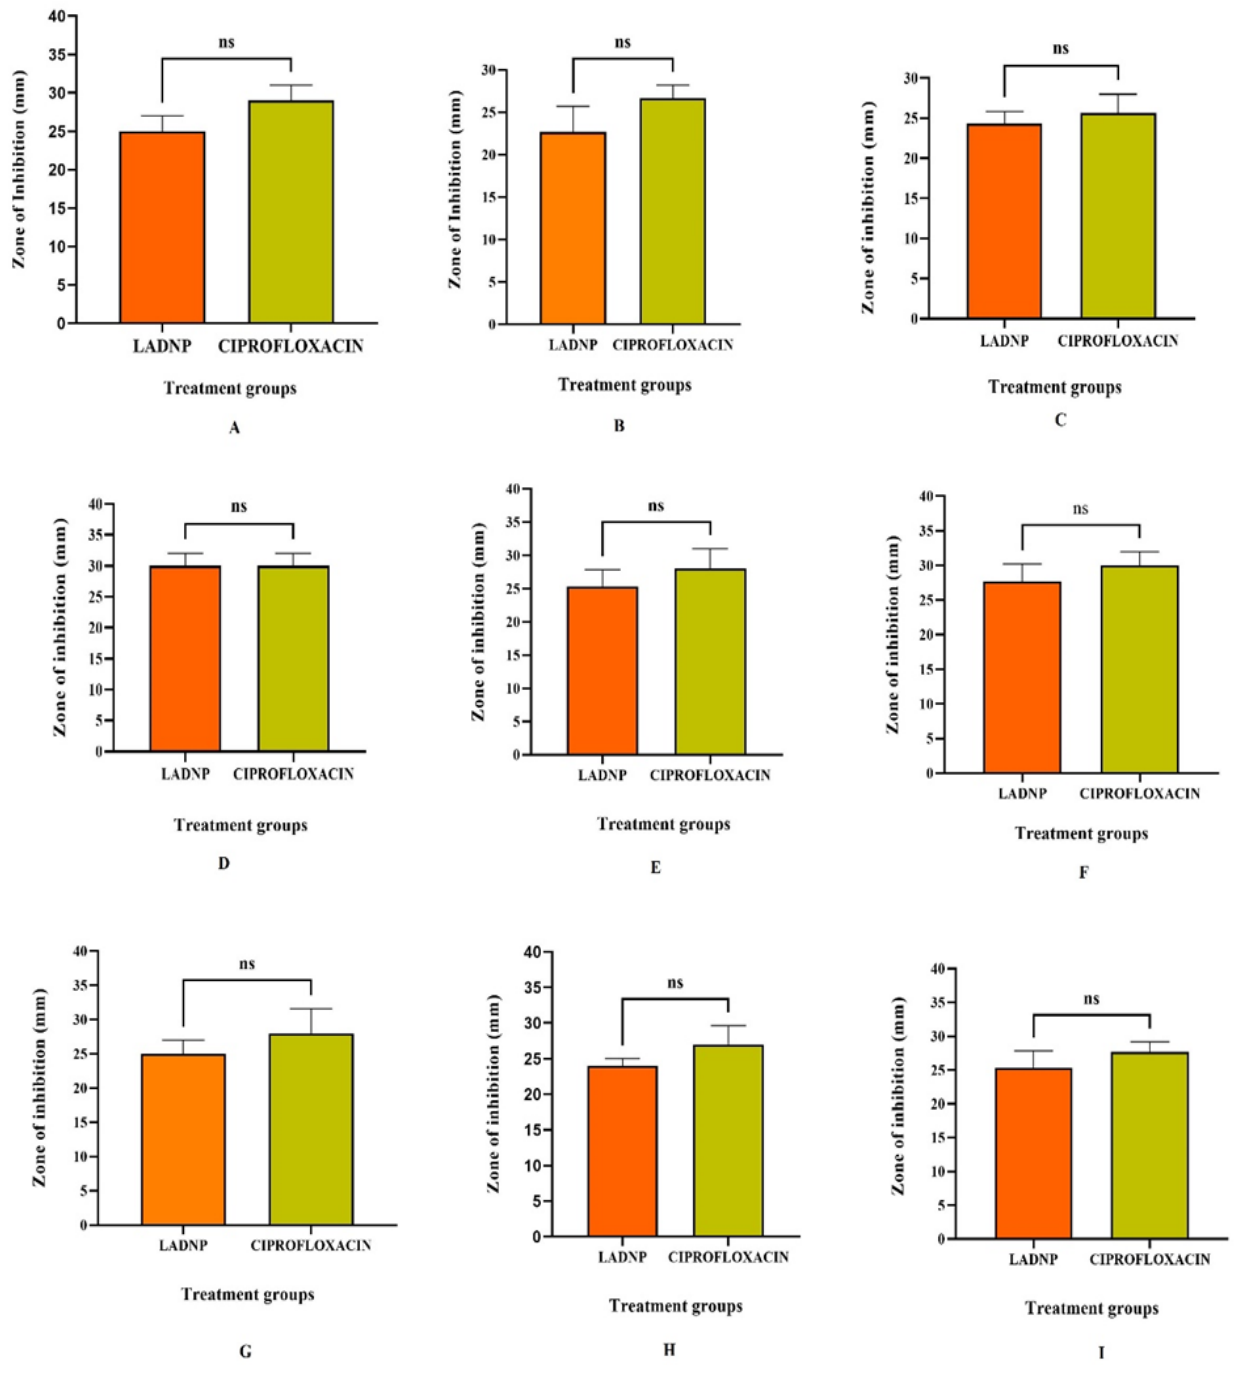
Figure 9. Comparative antibacterial spectral study. Amikacin sulfate dextran nanoparticles vs. Ciprofloxacin. ( A ) Against Bacillus subtilis at 2 × 10 5 CFU/mL concentration ( B ) Against Staphylococcus aureus at 4 × 10 5 CFU/mL concentration ( C ) Against Streptococcus pyogenes at 4 × 10 3 CFU/mL concentration ( D ) Against Escherichia coli at 3 × 10 5 CFU/mL concentration ( E ) Against Pseudomonas aruginosa at 2 × 10 3 CFU/mL concentration ( F ) Against Klebsiella pneumonia at 2 × 10 4 CFU/mL concentration ( G ) Against Proteus vulgaris at 3 × 10 3 CFU/mL concentration ( H ) Against Salmonella choleraesuis at 2 × 10 4 CFU/mL concentration ( I ) Against Enterococcus facalis at 4 × 10 3 CFU/mL concentration. ns: non - significant.